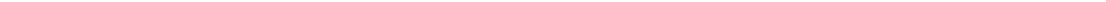
Fig. 1 Identi fi cation of a stem cell-state-speci fi c gene expression pattern. a Heat-map of expression of 24 genes (Ct values) for freshly isolated single HSCs and MPPs. Expression values combined and clustered for HSC, MPP1, MPP2, and MPP3 cells (Number of single cells for HSC n = 28, MPP1 n = 28, MPP2 n = 31, MPP3 n = 37, total n = 124). Colored squares indicate the population of origin for each single cell ( red , HSC; green , MPP1; blue , MPP2; turquoise , MPP3). b Gene expression values of freshly isolated single HSCs and MPPs after principal component analysis (PCA). Individual cells are projected on the fi rst two principal components PC1 and PC2. Colored points belong to the indicated populations ( red , HSC; green , MPP1; blue , MPP2; turquoise , MPP3). Assuming Gaussian distributions, ellipses show the 75% regions of highest density. c PC1 and PC2 coef fi cients for all single cells are shown on boxplots. Center lines indicate mean. Box limits indicate twenty- fi fth percentile and seventy- fi fth percentile. Whiskers indicate extreme data points excluding outliers. Crosses indicate outliers. d Eigen values of the 24 principal components, indicating the contribution level of principal components PC1 and PC2 selected for the two- dimensional analysis. e Heat-map of the coef fi cients of PC1 and PC2 vectors, corresponding to the weights attributed to each gene by each principal component. f Violin plots showing the distribution of gene expression levels for 12 selected genes between HSC, MPP1, MPP2 and MPP3. Genes selected based on ANOVA on HSCs and MPPs ( p ≤ 0.01). Squares indicate the mean. Vertical lines indicate the standard deviation. Gray areas indicate Kernel probability density. Horizontal lines indicate signi fi cance in t -test pairwise comparisons with p ≤ 0.01. See also Supplementary Fig.